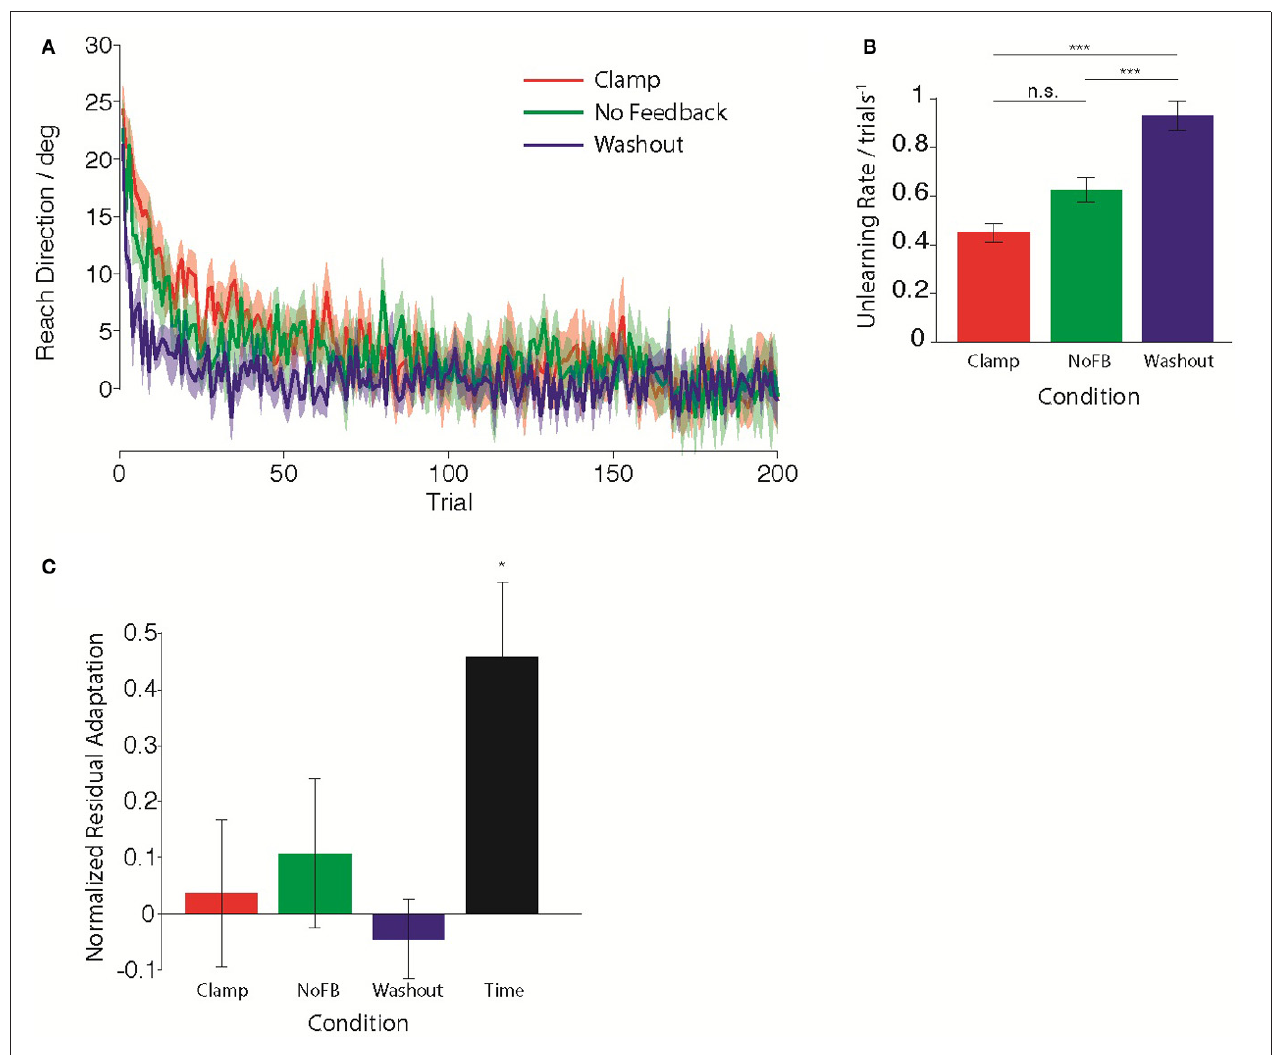
FIGURE 2 | Behavior during the Unlearning epoch. (A) Mean timecourse of unlearning in the Clamp (red), No Feedback (green), and Washout (blue) groups. Zero reflects baseline behavior. Shaded error bars indicate standard error in the mean across subjects. (B) Mean unlearning decay rate. (C)